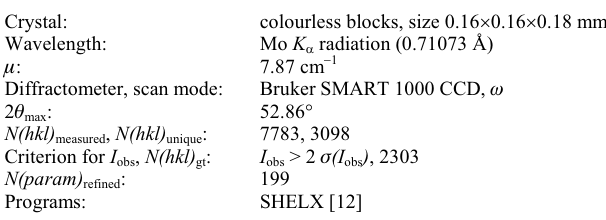
Table 1. Data collection and handling.